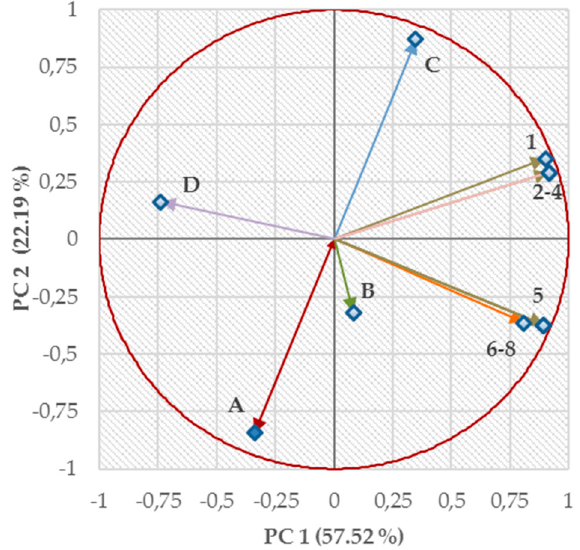
Figure 2. 2D mapping of loadings of variables (variously colored vectors) indicating their (i) positions towards a circle of correlation and (ii) relationships with both principal component 1 (PC 1) and 2 (PC 2). The assignment (numbering) of the vectors is as follows: A (vector assigned to the variable γ ), B (log ε 2 (Ch-T) ), C (log k w ), D (IC 50 ), 1 (vector built on log (1 / MIC (M)) values, which are connected with the in vitro testing of compounds 1a – 1p against E. faecalis ), 2 (VRE 368), 3 (VRE 725B), 4 (VRE 342B), 5 (SA 29213), 6 (MRSA SA 3202), 7 (MRSA SA 630), and 8 (MRSA 63718).